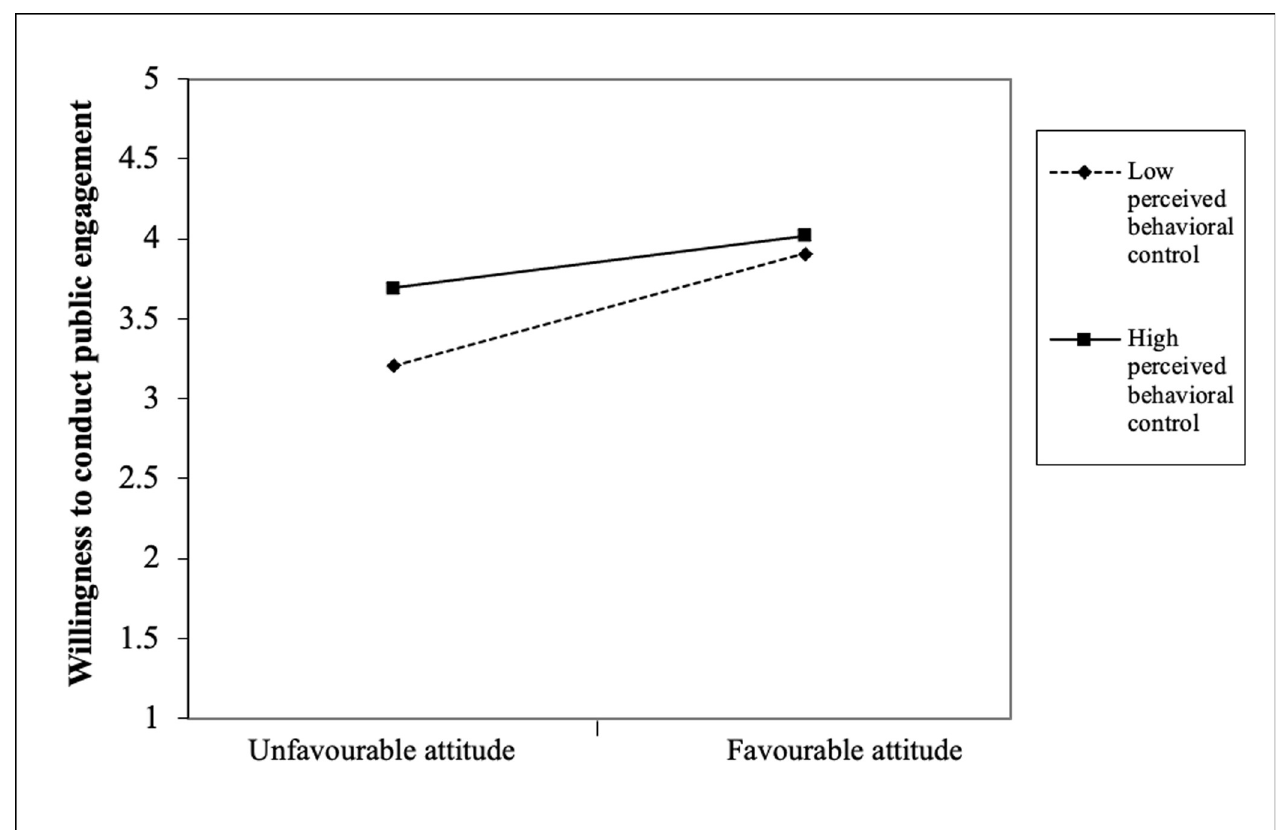
Fig 1. Perceived behavioral control as a moderator of the attitude-willingness